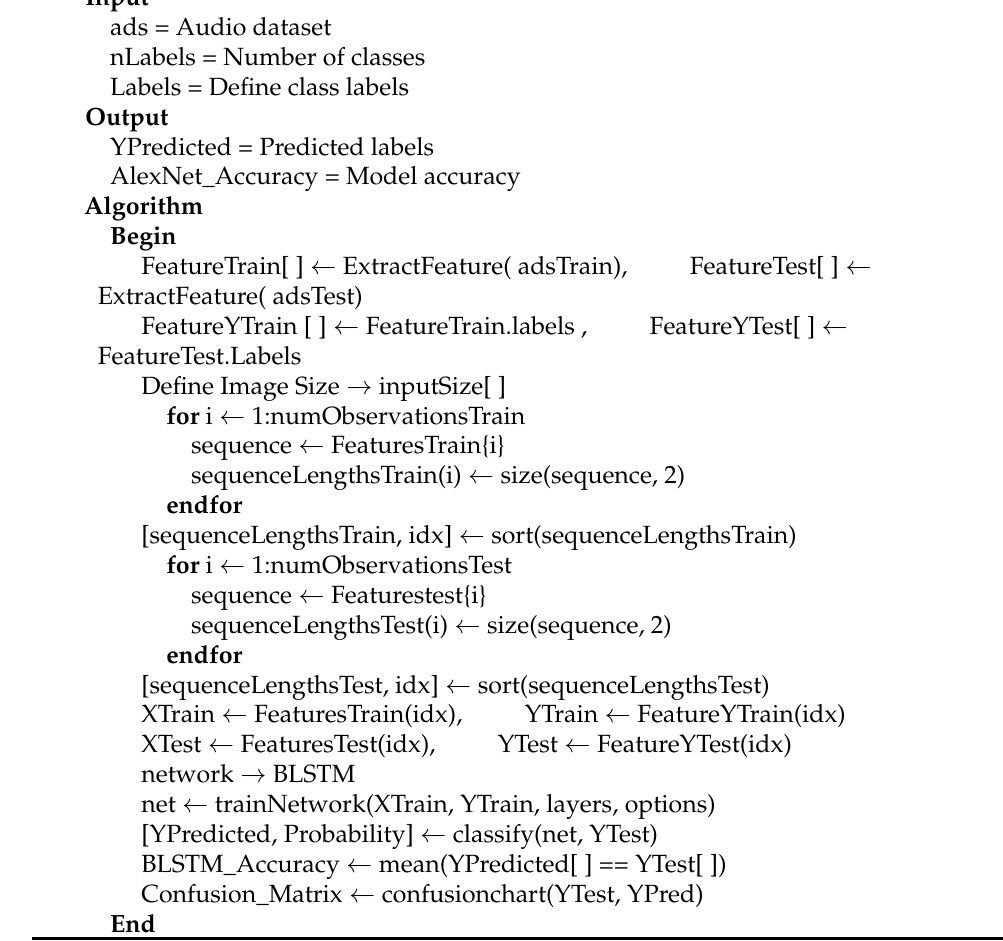
Algorithm 3: Classification task using a recurrent neural network (BLSTM).